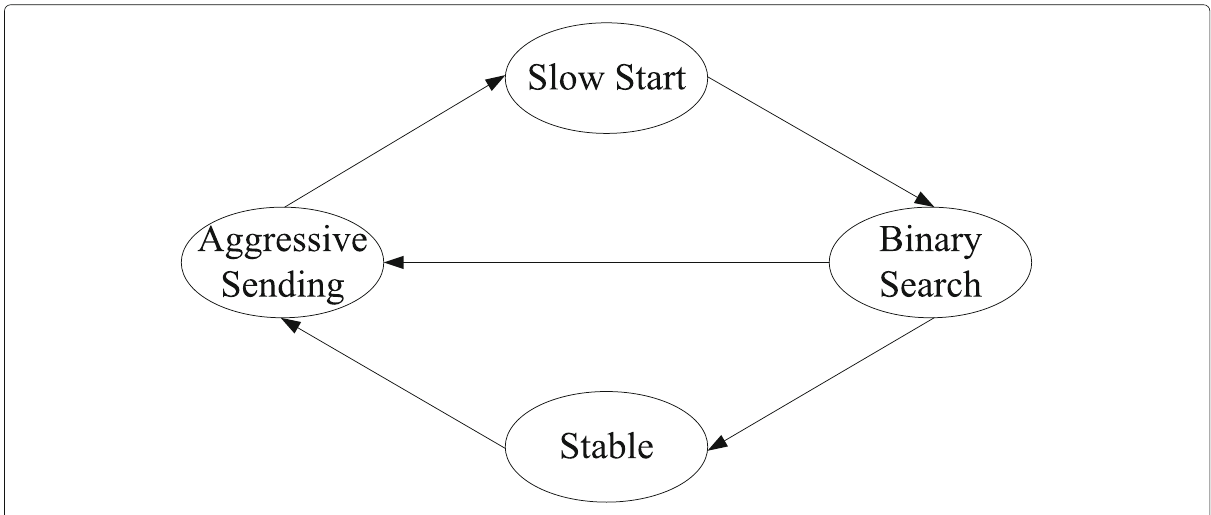
Fig. 7 States and state transitions in Algorithm